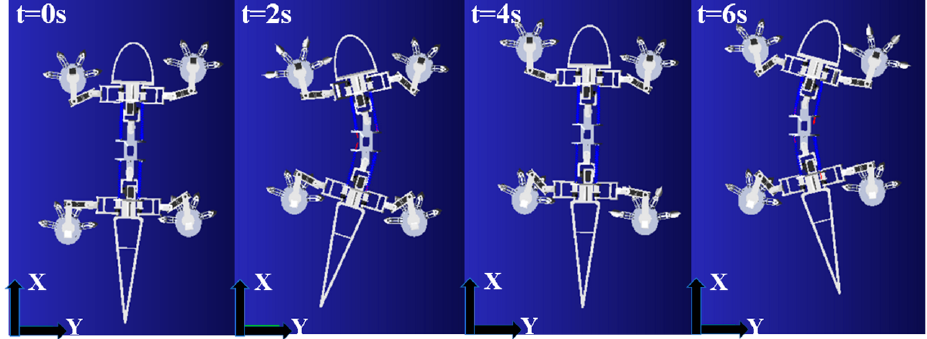
Figure 8. Gait simulation of robot forward walking.